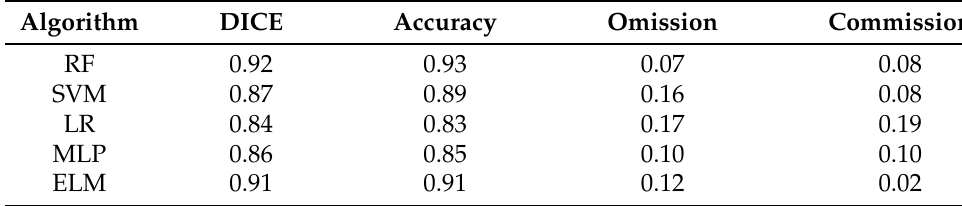
Table 6. Best model performance over the DELTA dataset for the test